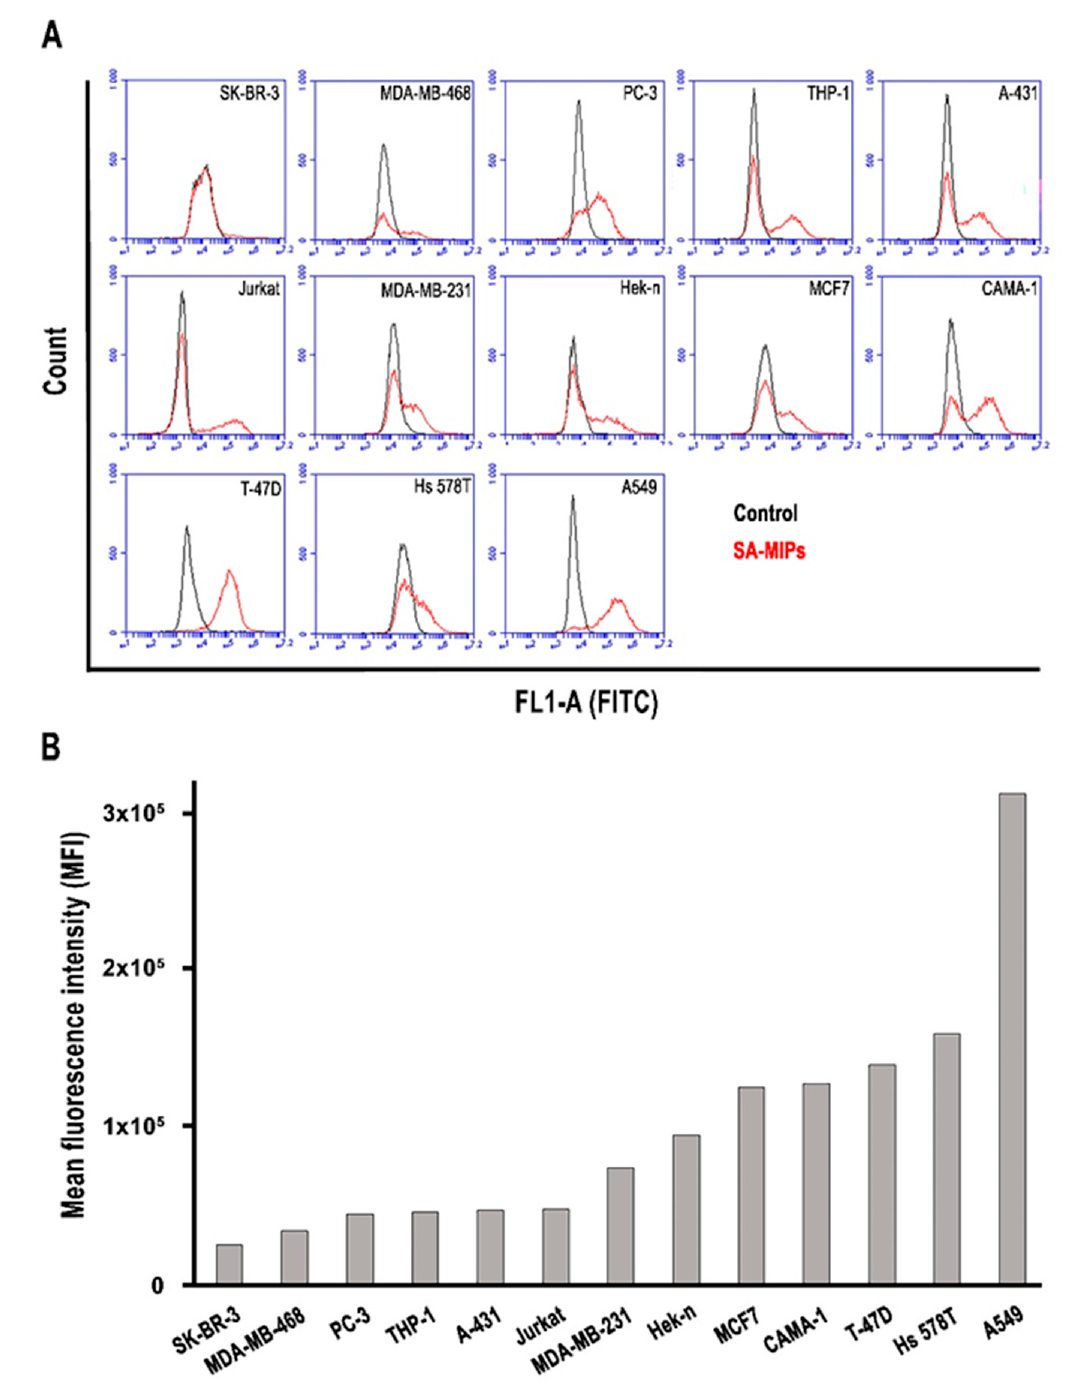
Figure 2. SA-MIP binding to the thirteen cancer cell lines as shown by MFI. The concentration of SA-MIPs is 0.1 mg/mL. ( A ) The flow cytometry histograms show the MFI of unstained control cells (black lines) and SA-MIP-stained cells (red lines); ( B ) the bar diagrams show the MFI of SA-MIP-stained cells. One representative experiment out of two performed is shown.